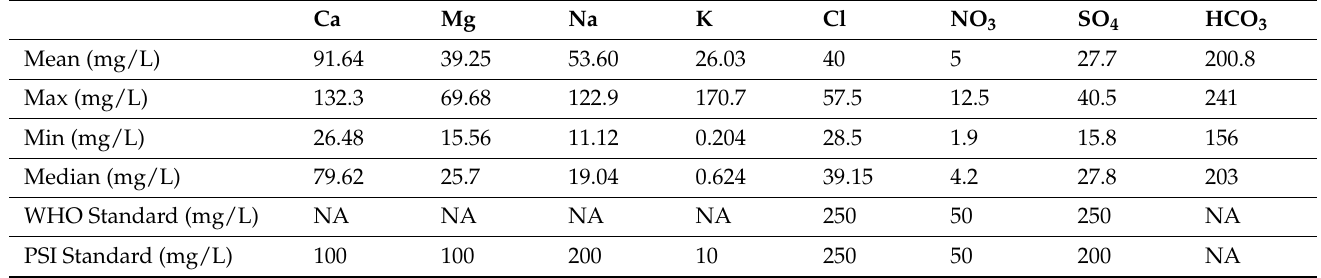
Table 4. Overview of the results for analysis of 50 springs in the West Bank sampled for major cations and anions and comparison with the limits of WHO and PSI standards.